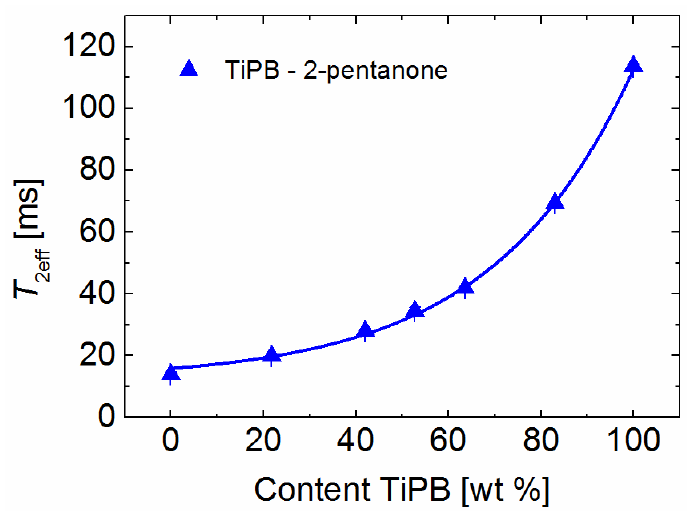
Figure 2. Correlation of the relaxation times with the solvent content in a binary mixture as exemplarily shown for TiPB/2-pentanone. The line depicts the fit result using the equation T 2eff_mixture = 3.72 × exp(content/30.3) + 12 with a correlation factor higher than 0.99. The relaxation times were measured at room temperature.